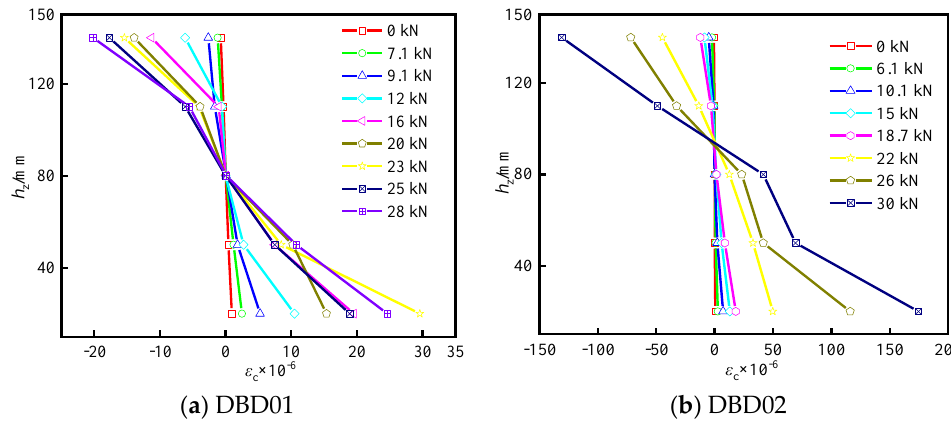
Figure 13. The concrete strain distribution along the section height in the mid-span.